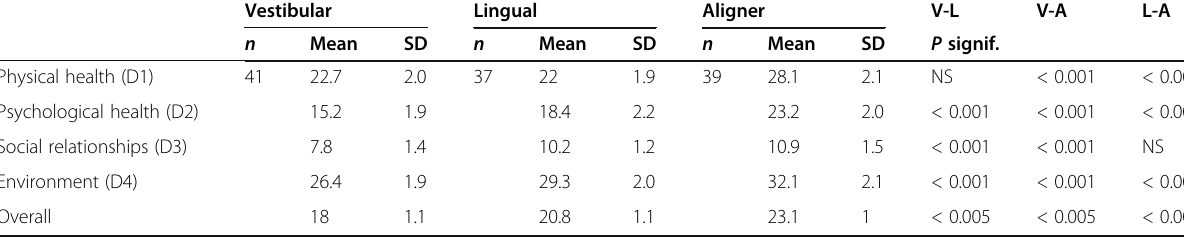
Table 2 QoL of patients treated with vestibular, lingual, and aligner appliances Vestibular